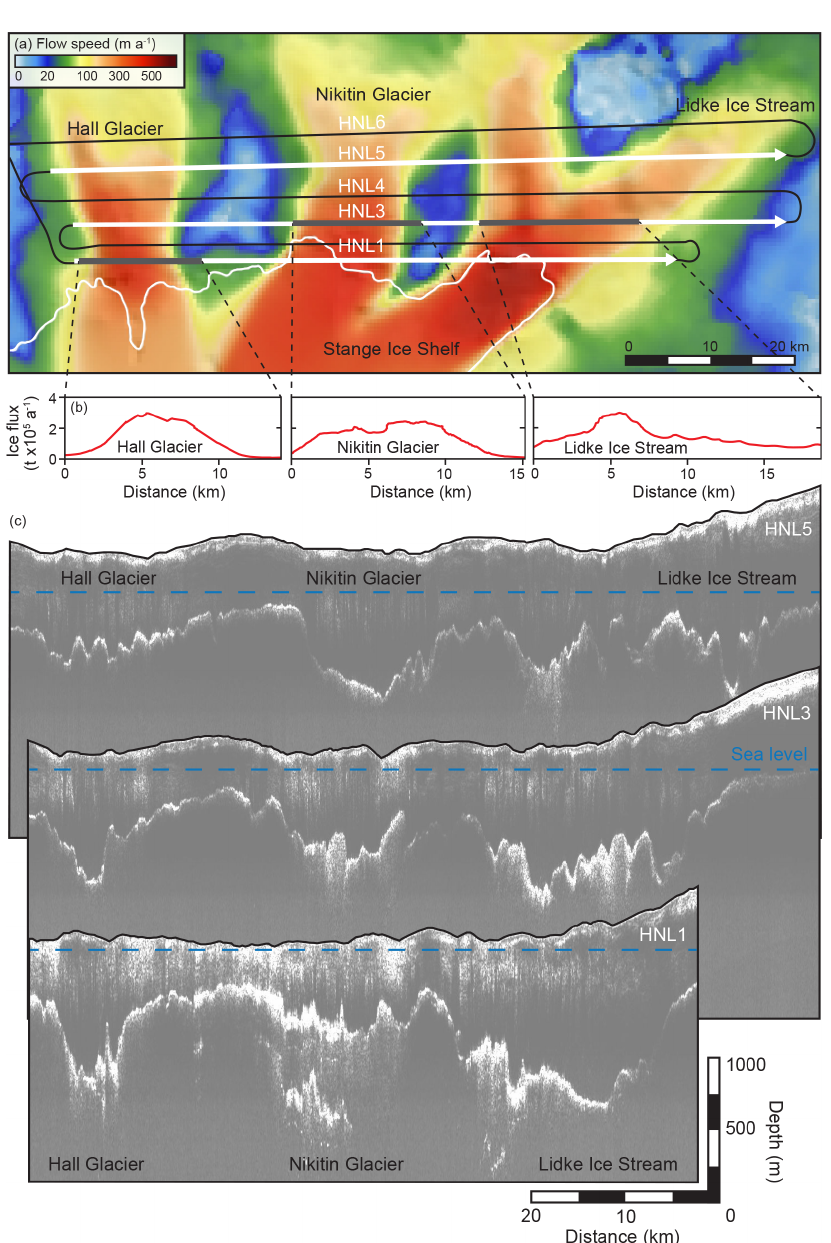
Figure 5. Hall Glacier, Nikitin Glacier, and Lidke Ice Stream transfer fast-flowing ice to the local grounding line (white), where ice flow coalesces in the Stange Ice Shelf. (a) Surface flow speeds from Mouginot et al. (2019a), superimposed with English Coast radargram tracks (black). The white arrows indicate the location and direction of radargrams presented in panel (c) , and thick grey lines denote ice flux gates, graphed in panel (b) . The white line indicates the ASAID grounding line (Bindschadler et al., 2011). Note that the map has been rotated 90 ◦ from its true orientation (shown in Fig. 1). Radargrams in panel (c) reveal changes in ice thickness and subglacial topography down-flow. Sea level is marked by a blue dashed